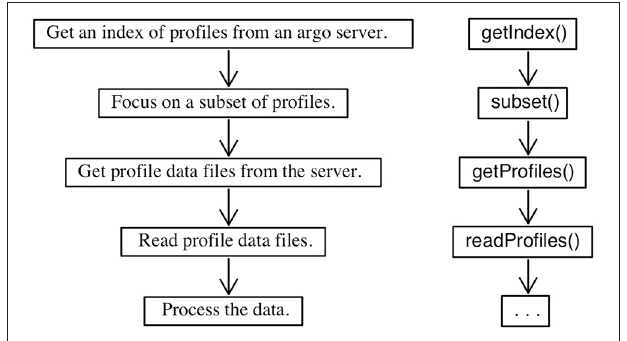
FIGURE 3 | Typical work flow of the argoFloats package with description of the steps on the left, and names of the relevant functions on the right.